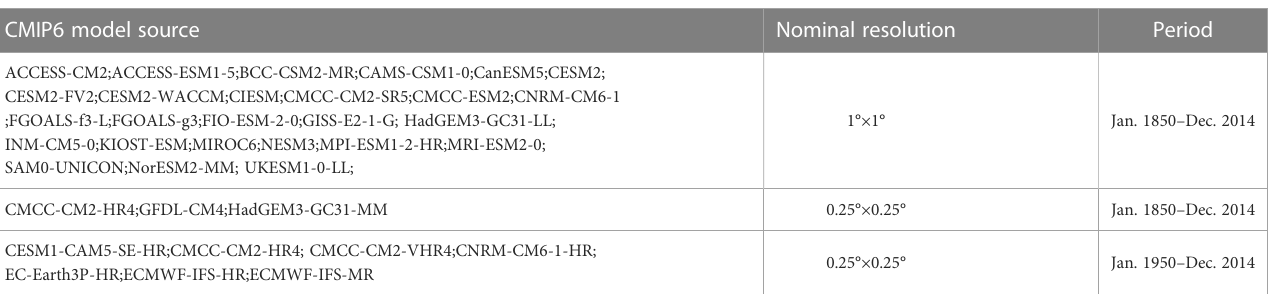
Figure3showstheCNNarchitectureusedinthisstudy,whichconsists of four convolutional layers and four pooling layers. The variables of the